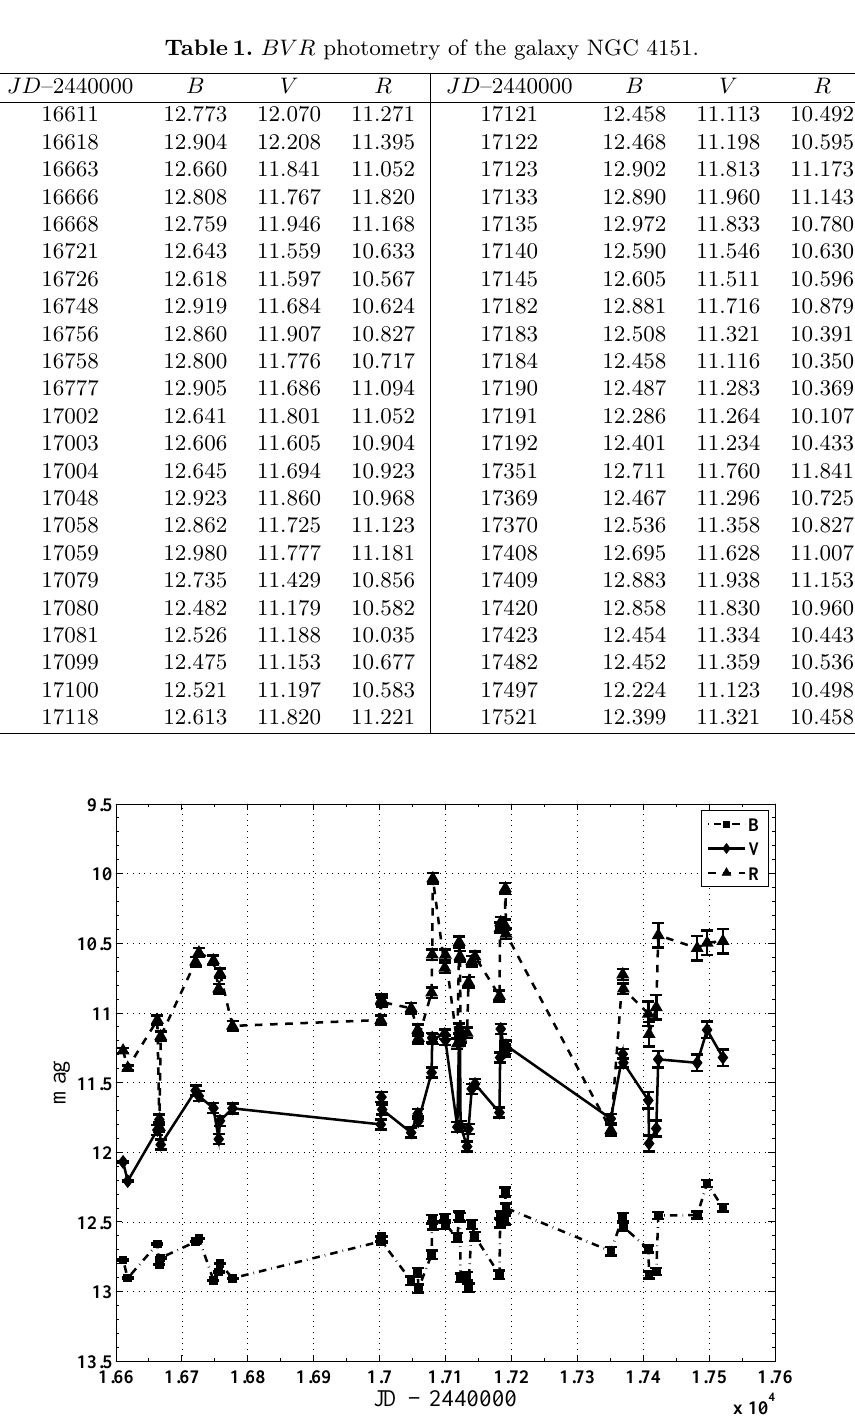
Fig. 3. Light curve of the galaxy NGC